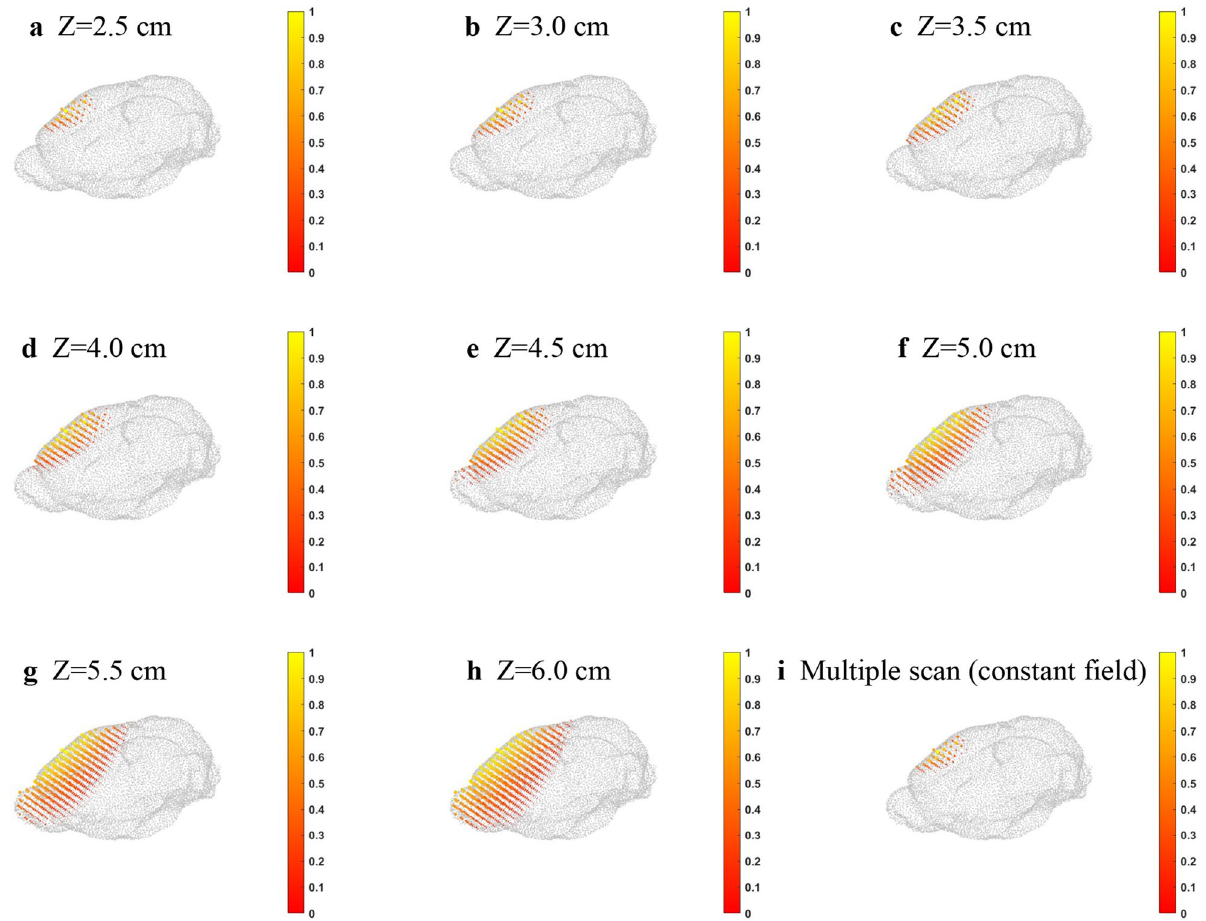
Figure 3. Inverse source distribution with Z position of the sensors at ( a ) 2.5 cm, ( b ) 3.0 cm, ( c ) 3.5 cm, ( d ) 4.0 cm, ( e ) 4.5 cm, ( f ) 5.0 cm, ( g ) 5.5 cm, and ( h ) 6.0 cm. ( i ) The combination of all scanning planes with different Z positions (multiple scan).